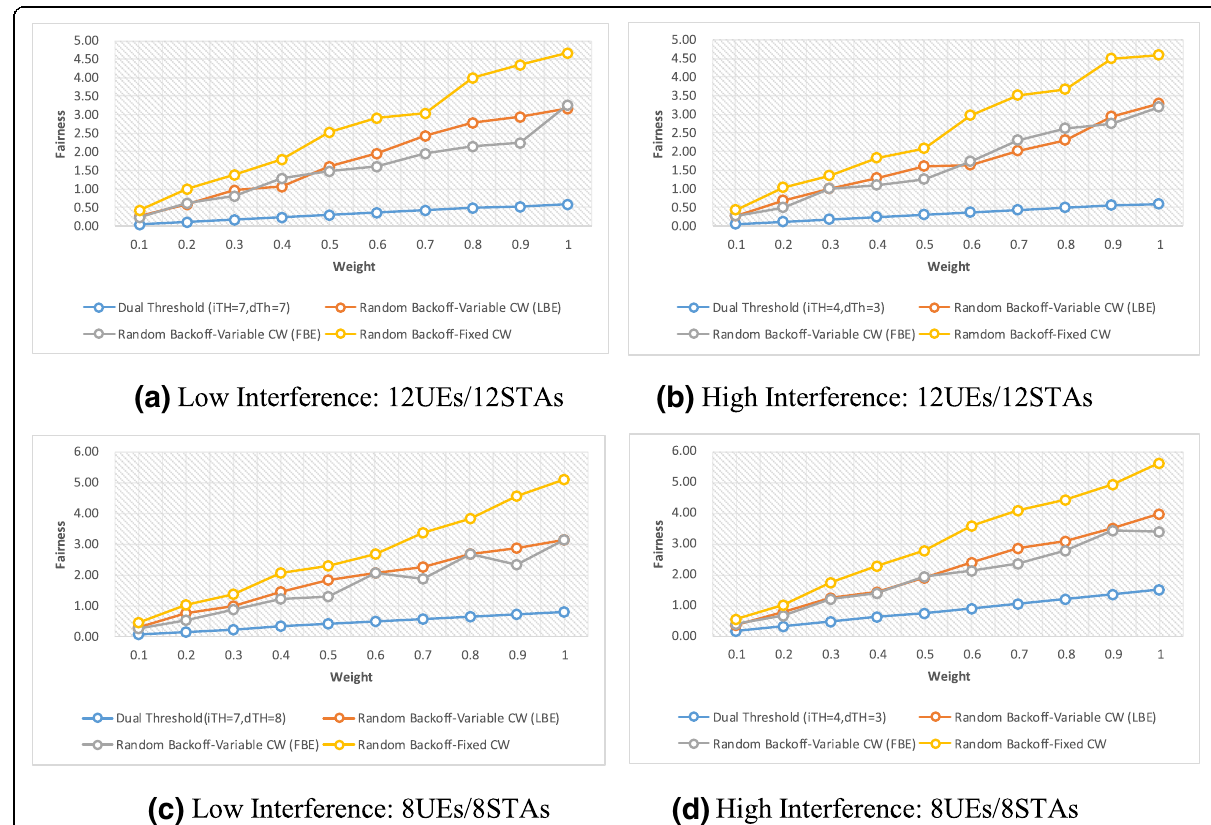
Fig. 11 Fairness comparison. a Low interference: 12UEs/12STAs. b High interference: 12UEs/12STAs. c Low interference: 8UEs/8STAs. d High interference: